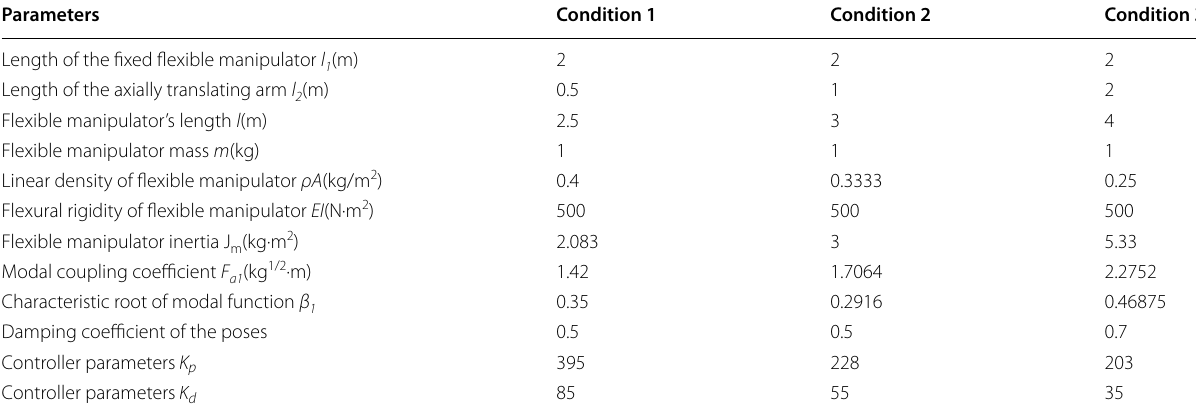
Table 3 Parameter of flexible